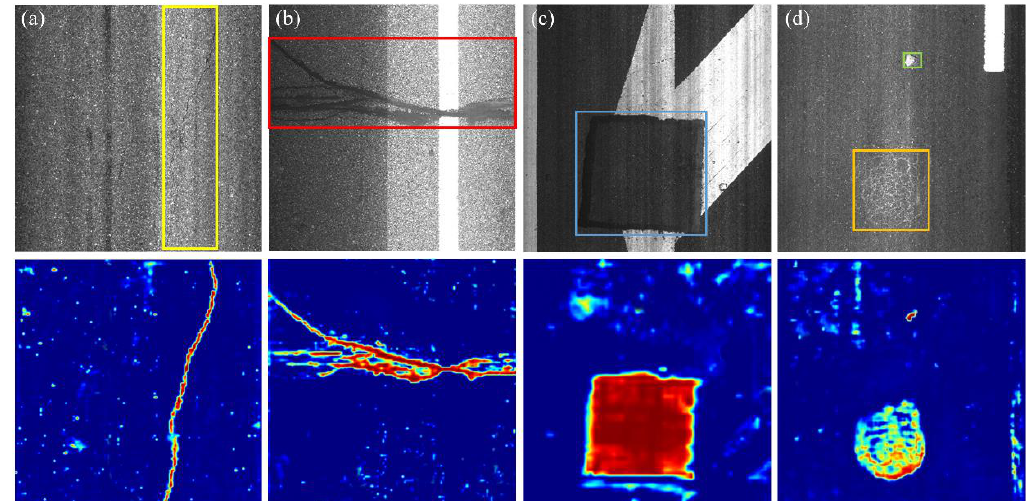
Figure 1. Five common types of damage. ( a ) Curvilinear damage. ( b ) Bar-like damage. ( c ) Block-like damage. ( d ) Grid-like and small damages. Damage is extremely susceptible to disturbance by complex backgrounds and unsatisfactory imaging conditions. Second row shows visualizations of the highest resolution feature map by the proposed backbone network.